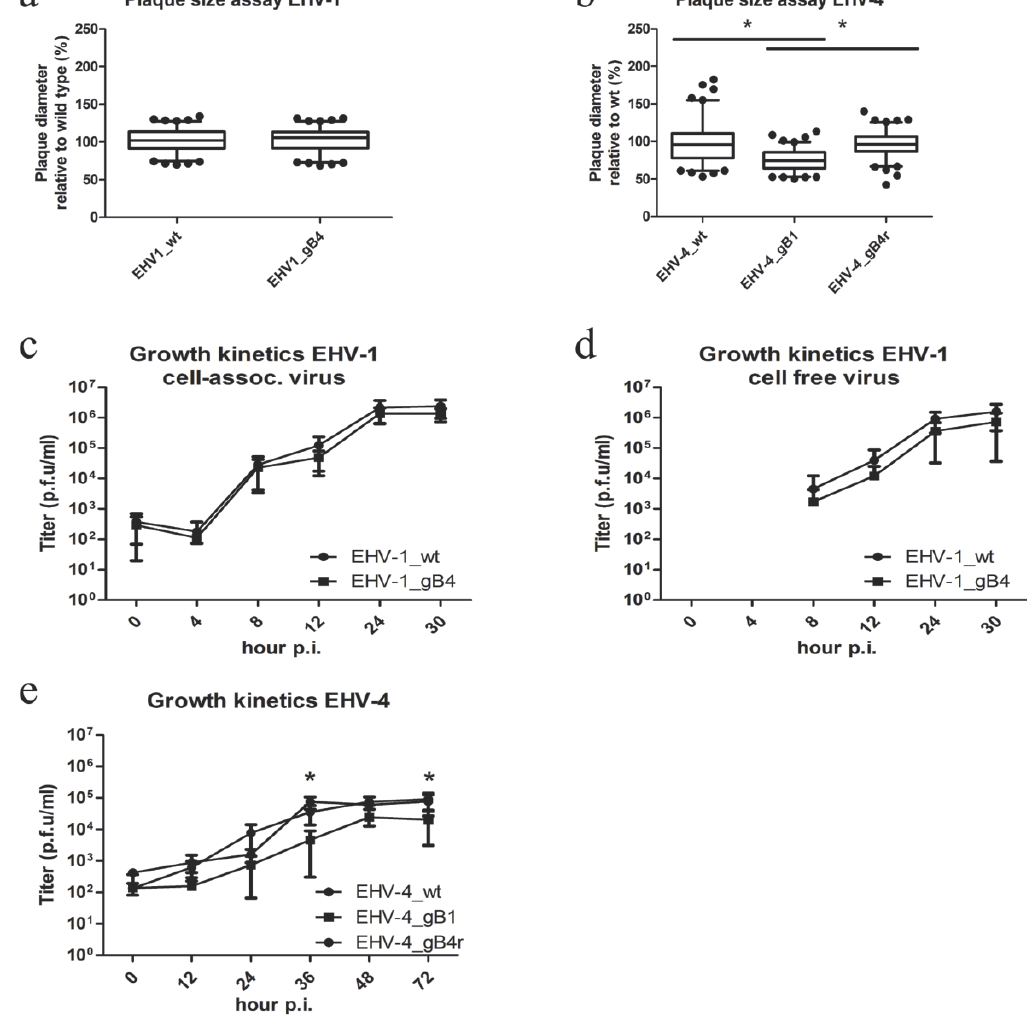
Figure 5. Growth characteristics of parental and recombinant EHV-1 and EHV-4 in cell culture. ED cells were infected with the respective viruses at a multiplicity of infection (MOI) of 0.01. Means ± SD of diameters of 100 plaques measured for each virus are shown. The plaque diameter of parental viruses was set to 100%. No significant differences (one-way ANOVA; p > 0.05) between parental EHV-1 and EHV-1_gB4 were obvious ( a ). A significant reduction (one-way ANOVA; p < 0.05) of plaque size for EHV-4_gB1